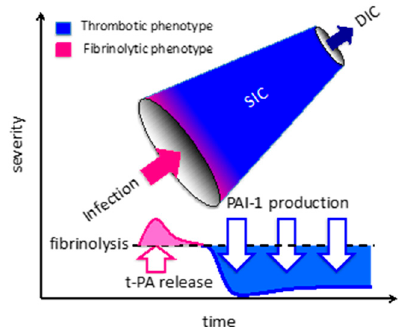
Figure 3. The sequential change from sepsis-induced coagulopathy to disseminated intravascular coagulation. Sepsis-induced coagulopathy progresses to disseminated intravascular coagulation (DIC) if the infection / inflammation is severe enough. Transient activation of fibrinolysis is observed initially, due to the release of tissue-type plasminogen activator (t-PA) from the vascular endothelial cells. Subsequently, the fibrinolytic system is suppressed by the production of plasminogen activator inhibitor-1. The imbalance between coagulation and fibrinolysis leads to a hypercoagulable state and organ dysfunction in